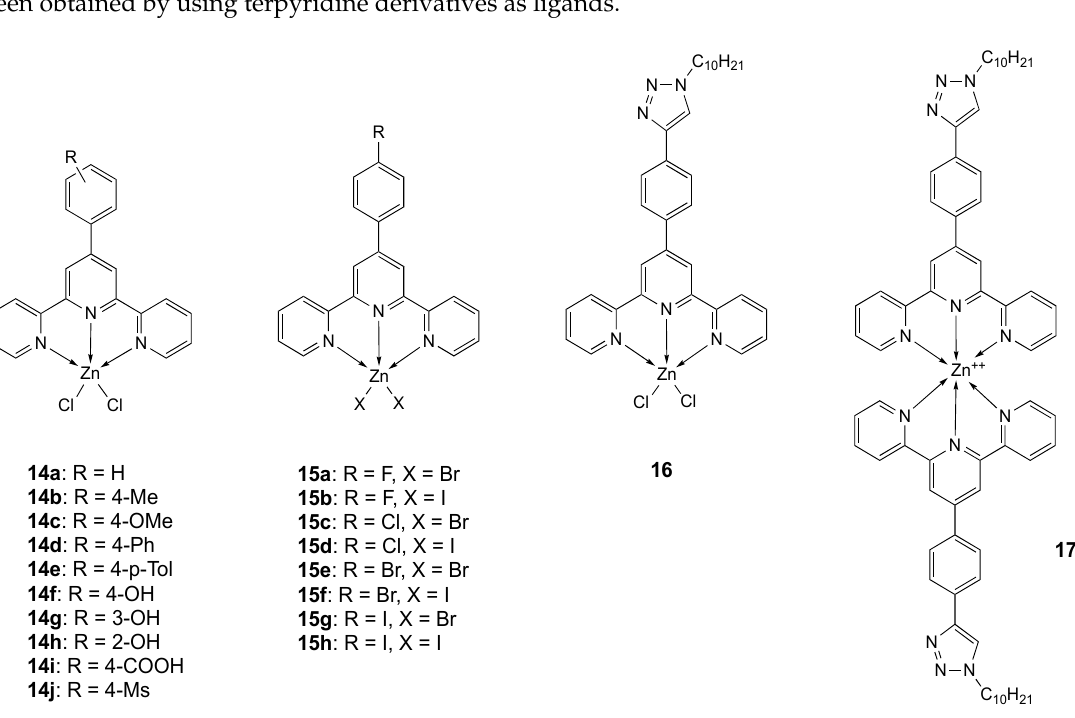
Figure 9. Structure of the zinc complexes 14 – 17 .